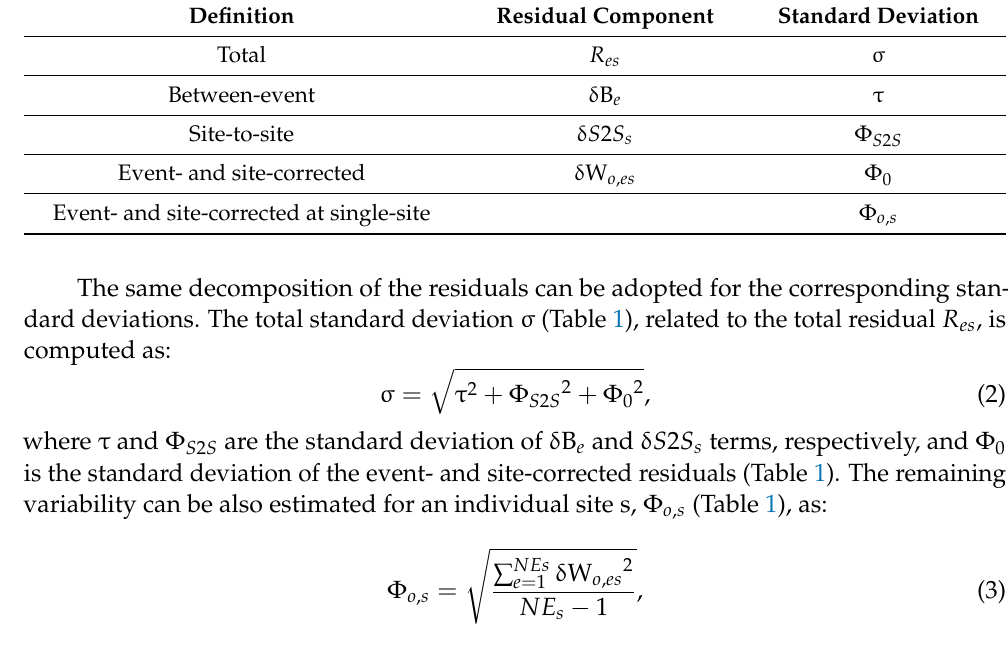
Figure 3. Residual components computed on the ITACAext flatfile, considering the ITA18 ground- motion model [25] as reference. Between-event residuals δB 𝑒 at T = 0.01 s ( a ) and T = 0.7 s ( b ). Between-station residuals δS2S 𝑠 at T = 0.01 s ( c ) and T = 0.7 s ( d ). Event- and station-corrected residuals δW 𝑜,𝑒𝑠 at T = 0.01 s ( e ) and T = 0.7 s ( f ). Gray dots: all data; white dots: mean values.